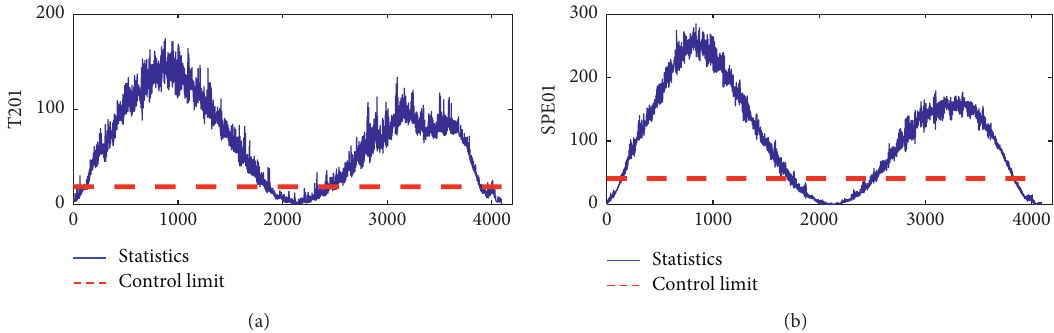
Figure 11: Mechanical failure comprehensive simulation experiment bearing outer ring failure results based on EMD-PCA.